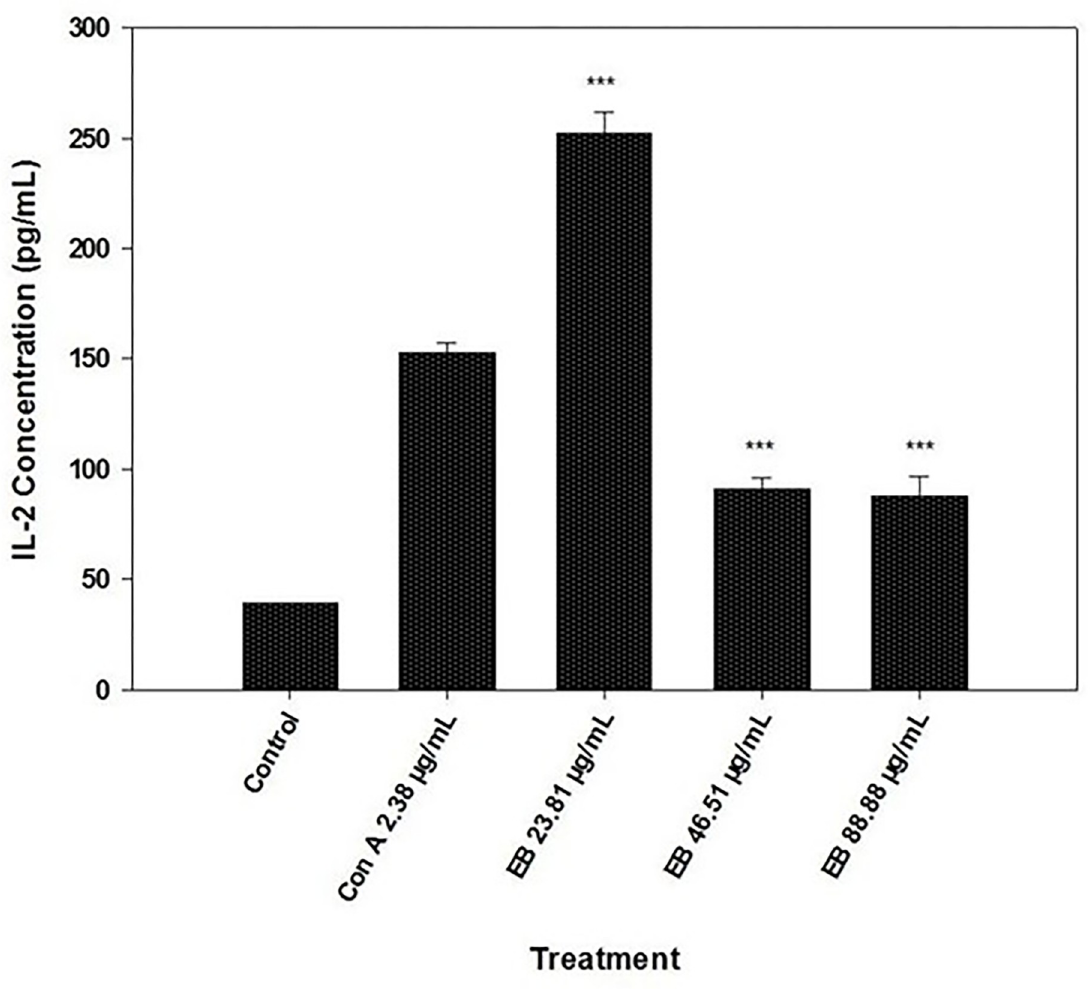
Fig 4. Quantification of fish IL-2 concentration in the prescence of Con A and various concentrations of elderberry extracts (23.81 μ g/mL, 46.51 μ g/mL, and 88.88 μ g/mL). All the elderberry extract concetrations were tested in the presence of Con A. Results are represented in means ± SEM. Asterisks represent a significant proliferation difference between treatment and control cell IL-2 production ( ��� = P < 0.001).